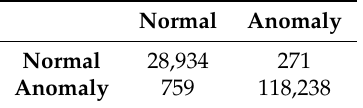
Table 9. Confusion matrix for Adaboost J48.